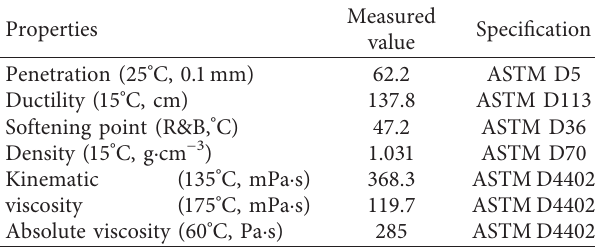
Table 1: Physical properties of 70#